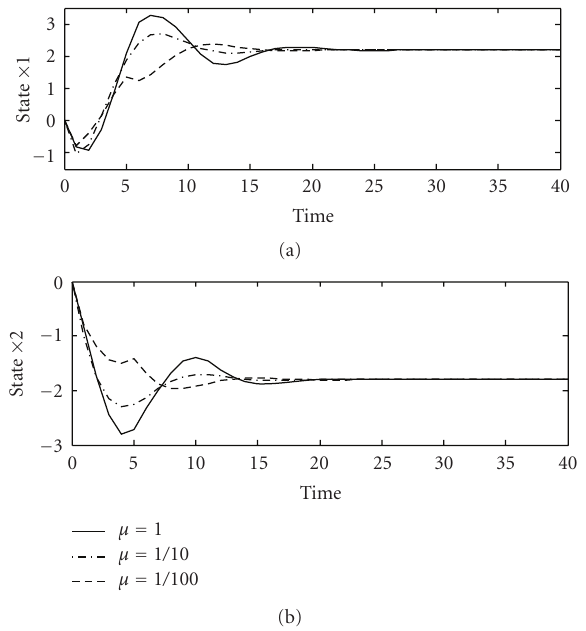
Figure 4: States of Tracking RMPC with di ff erent weighting values μ